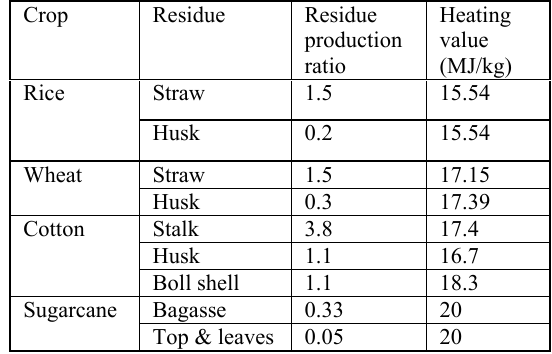
Table 3.1 Crop wise residue production ratio and heating